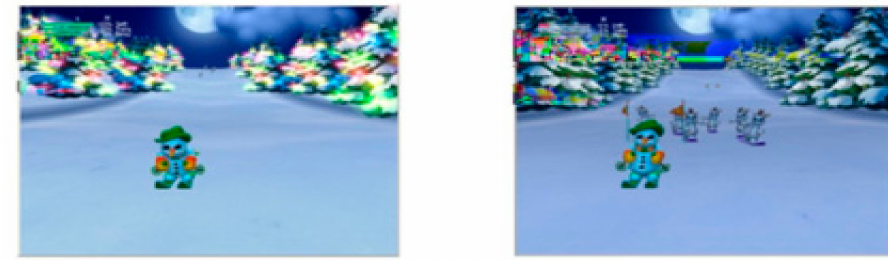
Figure 2. “Snowman” simulation board. Source: DigiTrack ® EEG System